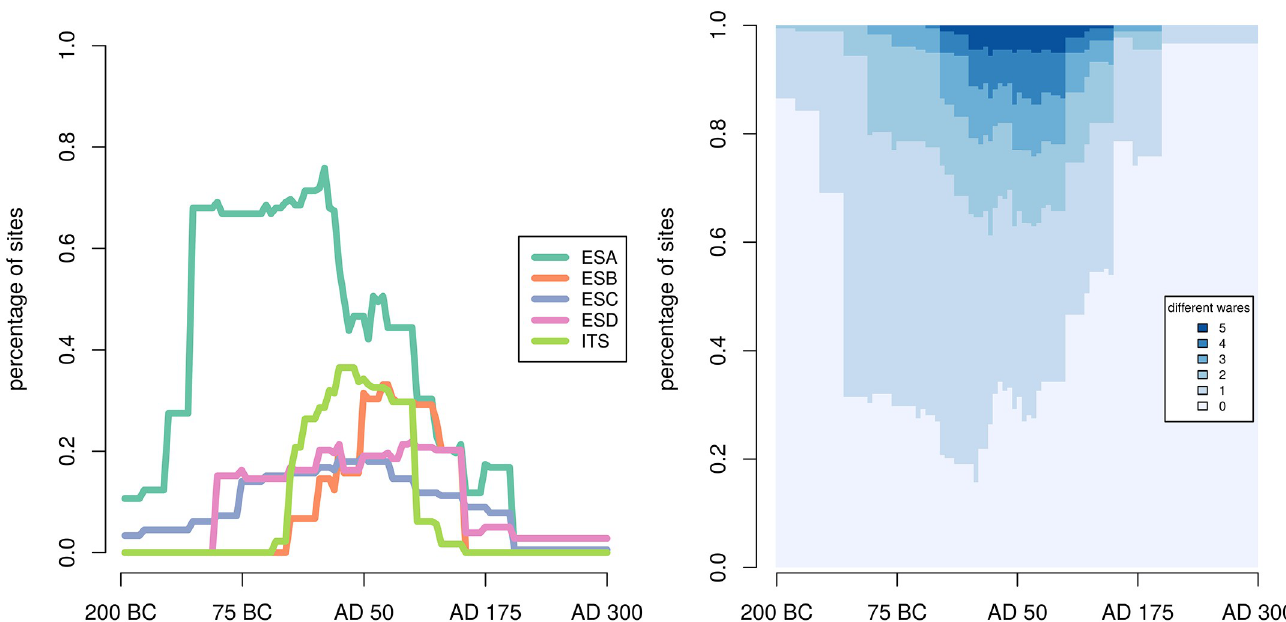
Fig 1. Data patterns. Data patterns derived from 8730 datable entries of 178 eastern Mediterranean sites from the ICRATES database. Left: percentage of sites with each pottery ware; note the disproportionate dominance of the earliest ware (ESA—teal), and its decrease with the introduction of the western-produced ITS (light green). We will later refer to this metric as Pattern A . Right: percentage of sites with a certain number of different wares. Note the dominance of sites with no or only one ware. We will refer to this metric as Pattern B . The two patterns capture two different aspects of the changes we are studying. Pattern A shows how each different tableware spreads to settlements throughout the time period under study, whilst pattern B shows how the diversity of tablewares changed from one settlement to another and over time. To ensure that the models of social learning we explore capture both aspects of these changes we test their ability to reproduce both patterns A and B at the same